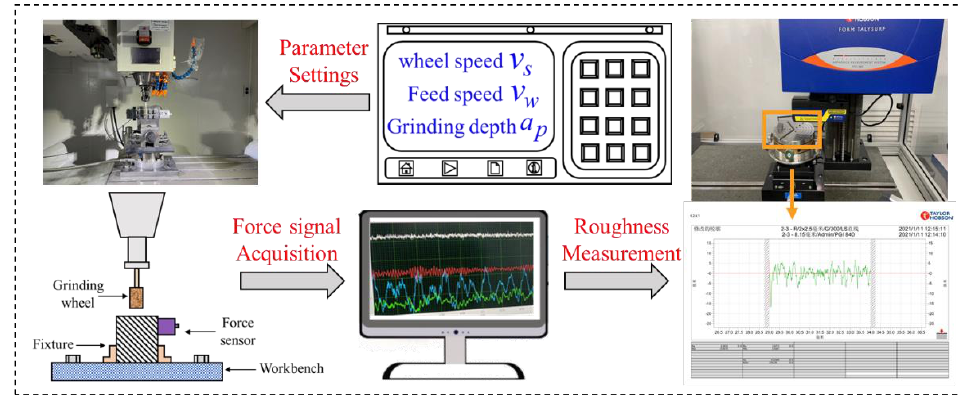
Figure 1. Experimental flow.